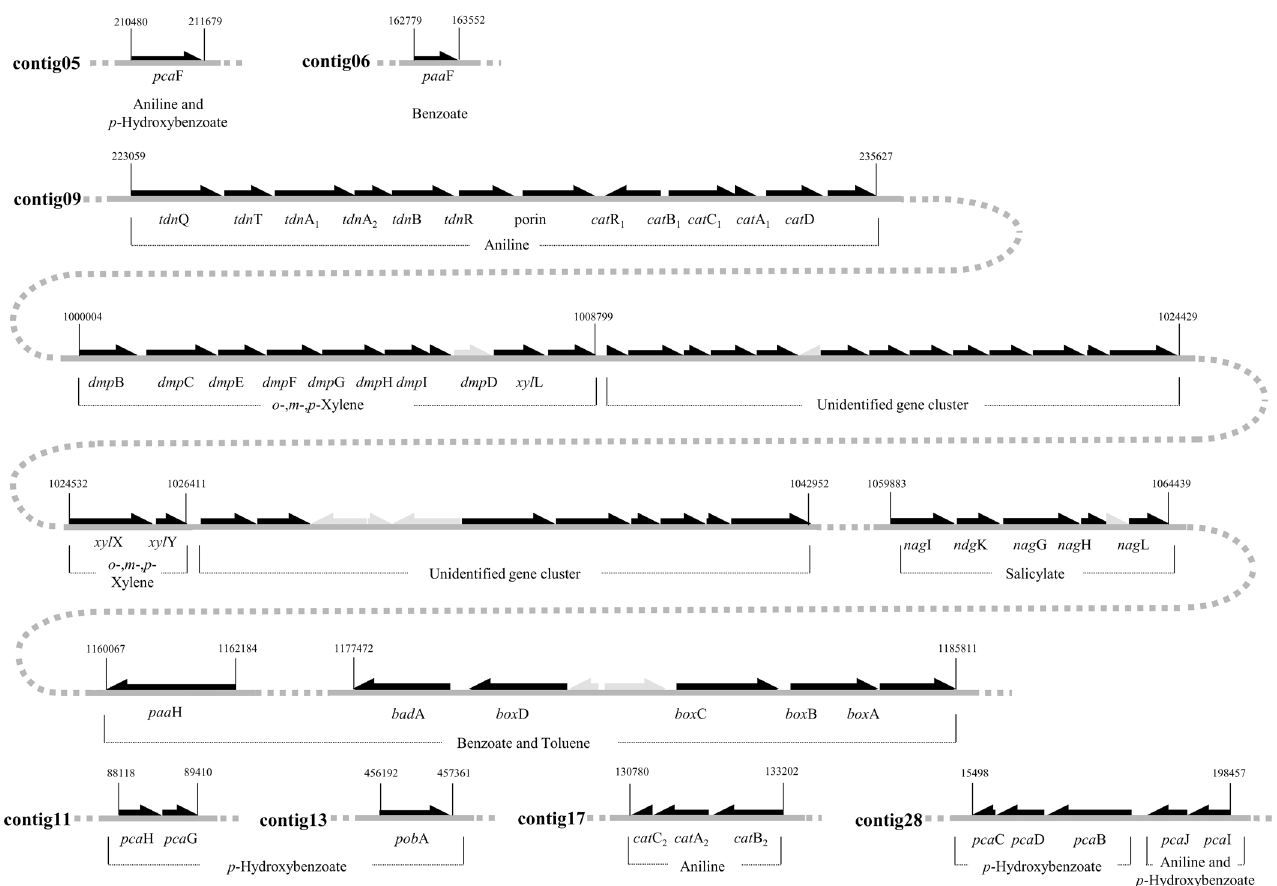
Fig 1. Organization of gene clusters involved in biodegradation of monocyclic hydrocarbons aniline, p -hydroxybenzoate, salicylate, toluene, benzoate, and xylene analogues in the Burkholderia sp. K24 genome.